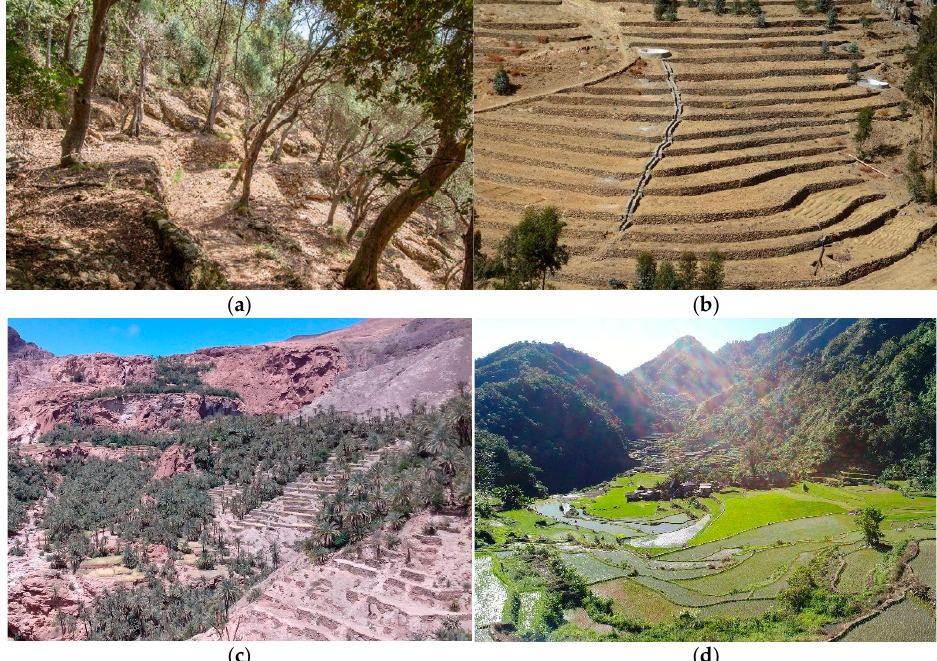
Figure 2. Case studies of the Special Issue; ( a ) Terraces in Portofino Promontory (Italy) [15], courtesy of F. Faccini; ( b ) Newly established terraces in Ethiopia [14], courtesy of S. Mesfin; ( c ) Terraces of Anti-Atlas (Morocco) [17], courtesy of V.Boselli; ( d ) Philippine Cordilleras Rice Terraces [18], courtesy of Y. Mori.